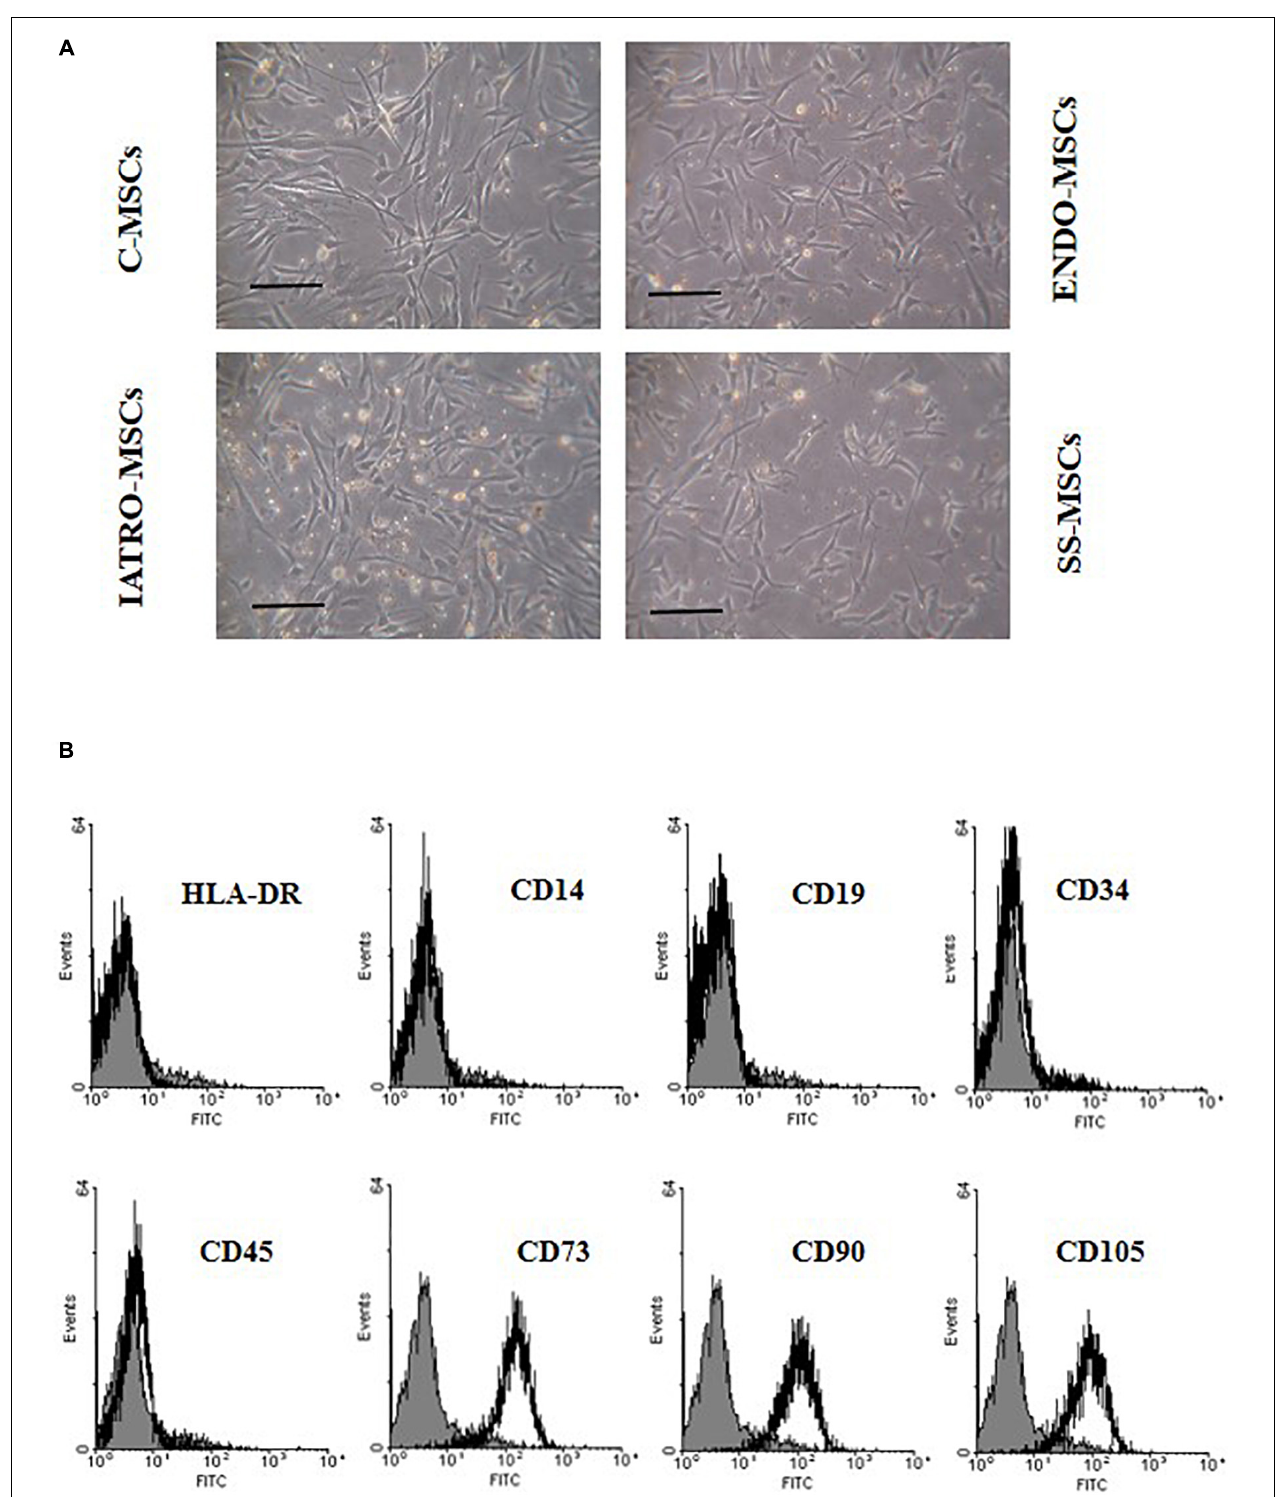
FIGURE 1 | Cell morphology and immunophenotype of MSCs. (A) Phase-contrast images of MSCs derived from skin of control subjects (C-MSCs) and from skin of patients affected by endogenous cushing syndrome (CS) (ENDO-MSCs), iatrogenic CS (IATRO-MSCs), and iatrogenic CS under treatment with steroid sparing (SS-MSCs) Scale bar = 100 µ m. (B) Representative FACScan analyses of cell-surface antigen expression, as indicated. Solid gray histograms refer to the negative control (IgG1 isotype control-FITC labeled). No differences were observed between MSCs isolated from the different subgroups.